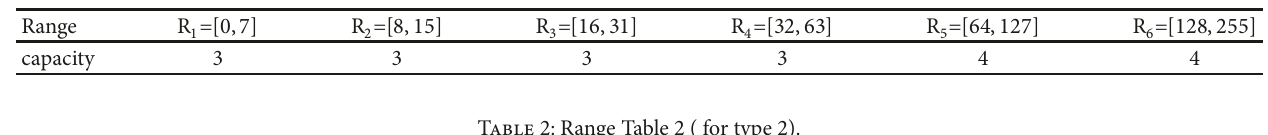
Table 1: Range table 1 (for type 1).